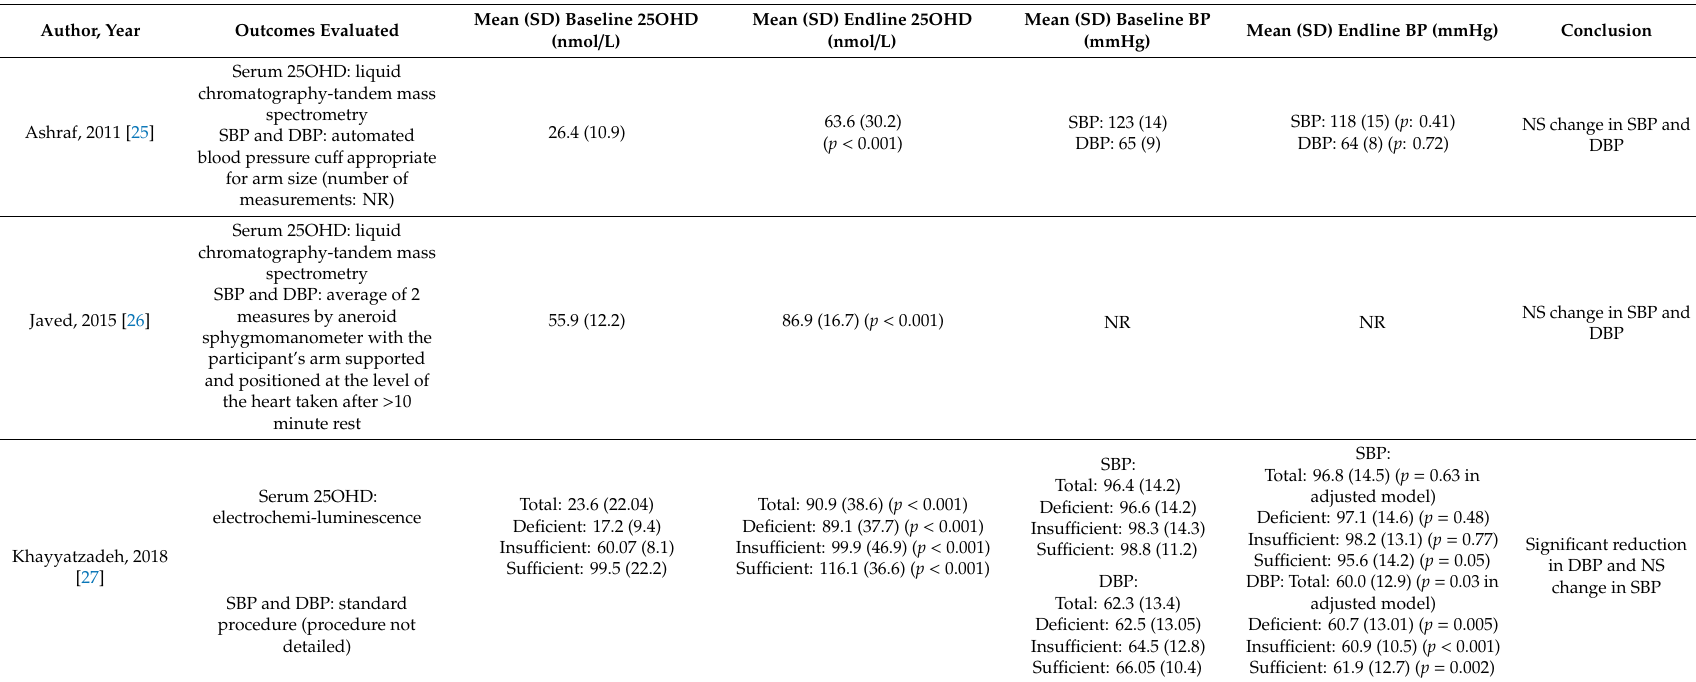
Table 3. Results of non-randomized human intervention